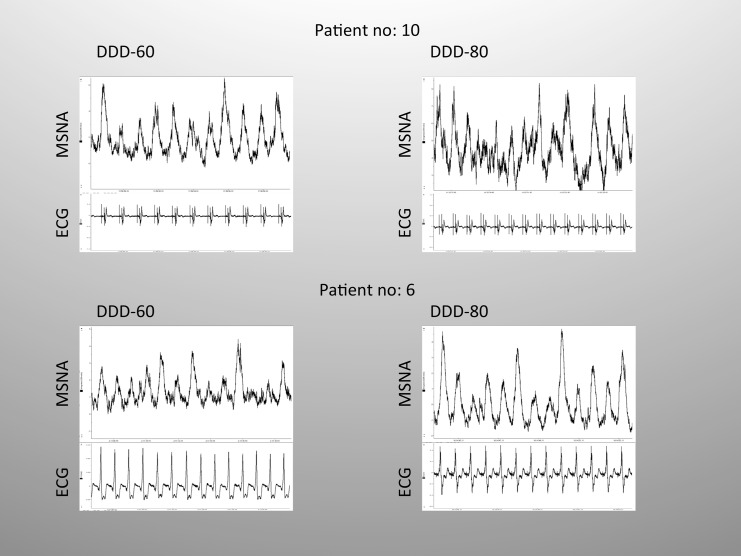
Examples of sympathetic activity and ECG recording.Mean voltage neurograms for MSNA and electrocardiograms (ECG) in two patients. Patient no. 10 (upper panel) had a significant decrease in sympathetic activity during the DDD-80 period, while patient no. 6 (lower panel) experienced an increase in sympathetic activity during the DDD-80 period compared to the DDD-60 period.